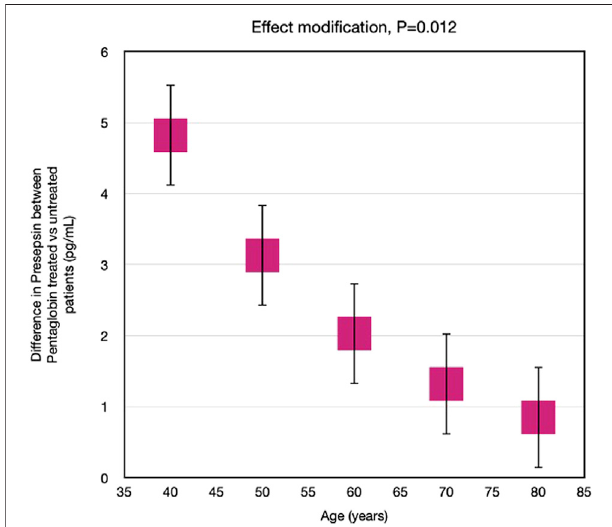
FIGURE 6 | Effect modi fi cation by age on the effect of Pentaglobin on presepsin. The effect of Pentaglobin for increasing Presepsin, compared to the control group, was strictly dependent on age. Through an advanced statistical technique (linear mixed models), the effect of Pentaglobin assuming thatall the patients inthe study wereofa certain age wasestimated (such an approach allows to overcome the problem of the reduced sample size in the various age groups). If all patients were 40 years old, the difference in presepsin (Pentaglobin treated patients versus controls) would be 4.82, if they were 50 years old the difference in presepsin would be 3.13, if they were 60 years old the difference in presepsin would be 2.03, if they were 70 years old the difference in presepsin would be 1.32, if they were 80 years old the difference in presepsin would be 0.86. Therefore, the reduction of presepsin determinedbyPentaglobinisgreatertheloweristheage.Thedifferenceinthe effect of the drug between the various ages is statistically signi fi cant ( p (cid:1) 0.012). Data are mean differences and 95%